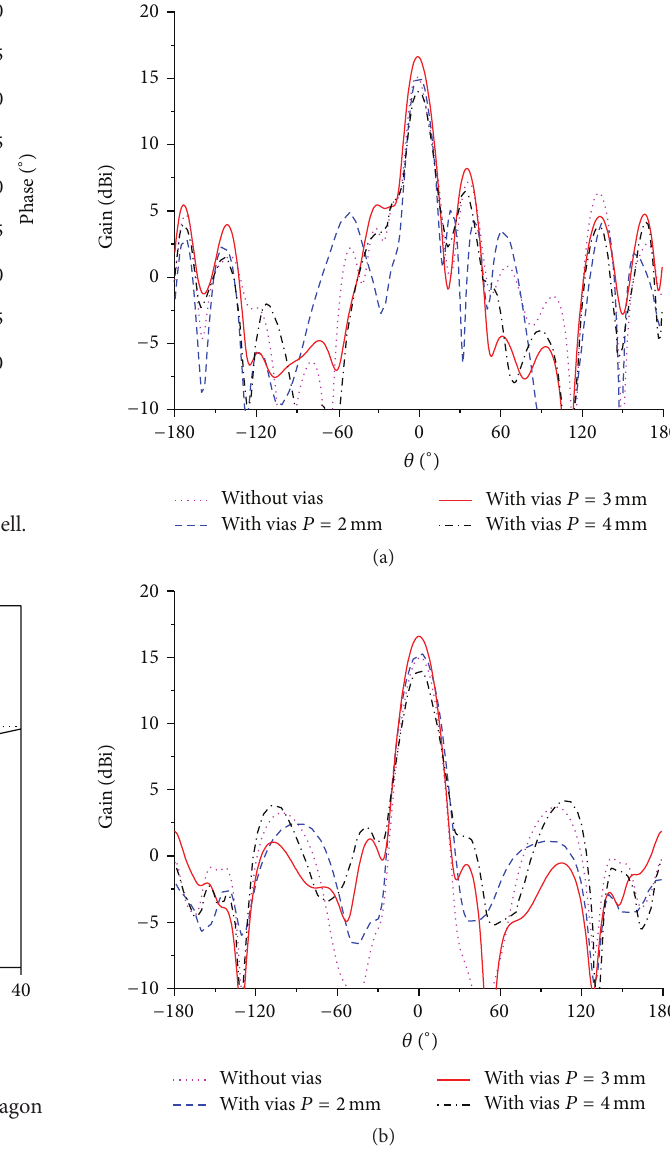
Figure 4: Simulated radiation patterns (a) E-plane ( 𝑦𝑜𝑧 ) and (b) H- plane ( 𝑥𝑜𝑧 ) at 35 GHz.